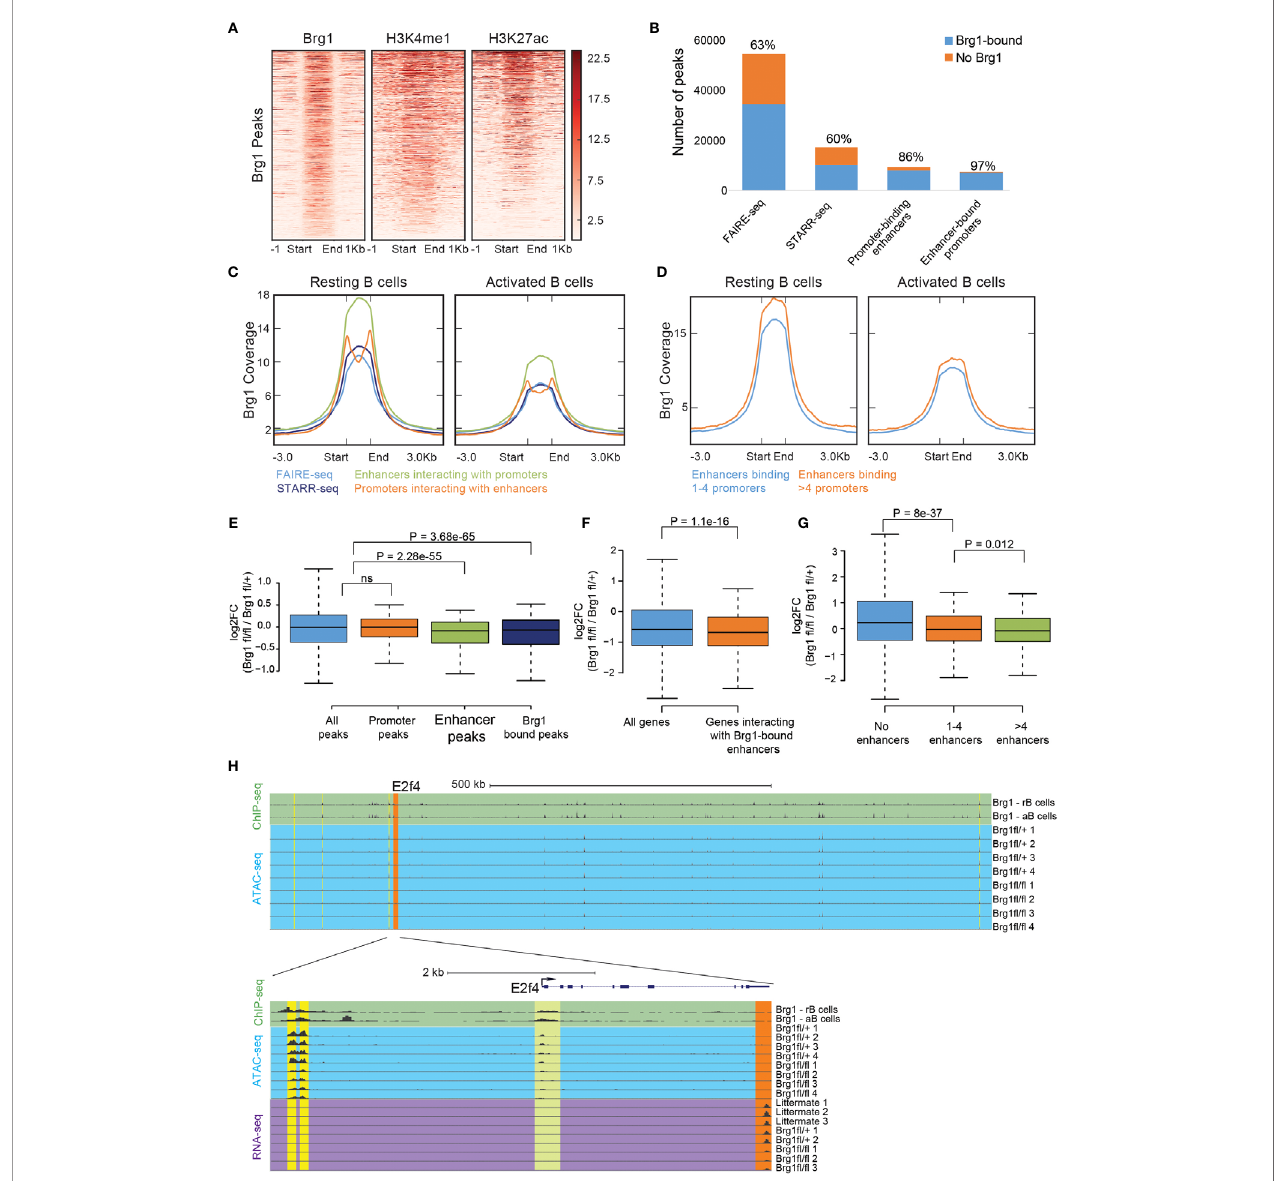
FIGURE 2 | Brg1 recruitment to multiple enhancers is associated with transcriptional activation of their coupled promoters. (A) Density of ChIP-seq reads for Brg1, H3K4me1, and H3K27ac in activated B cells. Plots show ±1 kb around the midpoint of each Brg1-enriched region ranked according to Brg1 density. (B) The numbers of FAIRE-seq peaks, STARR-seq peaks, promoter-binding enhancers, and enhancer-bound promoters, and the fraction of each group that overlaps Brg1 bound genomic regions. (C) Averaged tag densities of Brg1 are plotted across all FAIRE – seq peaks, STARR-seq peaks, promoter-binding enhancers, and enhancer-bound promoters, in resting and activated B cells. (D) Averaged tag densities of Brg1 are plotted across enhancers binding 1-4 promoters compared to enhancers binding >4 promoters, in resting and activated B cells. (E) Boxplots indicating the median, quartiles, and 5th and 95th percentiles of changes in ratios of ATAC-seq signal for the indicated group of peaks, comparing CD23-Cre Brg1 fl / fl cells to Brg1 fl /+ B cells; p>0.05 = ns (not signi fi cant). (F) Boxplots indicating the median, quartiles, and 5th and 95th percentiles of changes in expression levels of Brg1 fl / fl cells compared to Brg1 fl /+ cells in genes whose promoters interact with Brg1 bound enhancers compared to all genes. P-value was calculated by the two-sided Wilcoxon rank-sum test. (G) Boxplots indicating the median, quartiles, and 5th and 95th percentiles of changes in expression levels of CD23-Cre Brg1 fl / fl cells compared to Brg1 fl /+ cells in genes whose promoters interact with 1-4 enhancers or with more than 4 enhancers, compared to genes whose promoters were not found to interact with active enhancers. P values were calculated by a two-sided Wilcoxon rank-sum test. (H) Top: UCSC genome browser tracks showing the area around the E2f4 gene, which was signi fi cantly downregulated in Brg1 fl / fl cells (padj < 0.05). Tracks show the ChIP-seq signal of Brg1 in resting and activated B cells and ATAC-seq coverage in activated B cells. Orange highlight: E2f4 gene. Yellow highlights: enhancers which were found to interact with the promoter of E2f4. Bottom: zoom-in to the E2f4 locus, showing ChIP-seq signal of Brg1 in resting and activated B cells, ATAC-seq coverage and expression levels measured by RNA-seq. Green highlight: binding of Brg1 in the promoter region of E2f4. Orange highlight: 3 ’ end exons covered by RNA-seq. Yellow highlights: enhancers which were found to interact with the promoter of E2f4. rB cells, resting B cells. aB cells, activated B